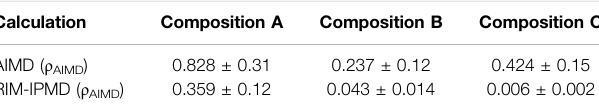
TABLE 4 | D Zr 4+ × 10 5 (cm 2 /s) values as calculated from AIMD and RIM-IPMD simulations.